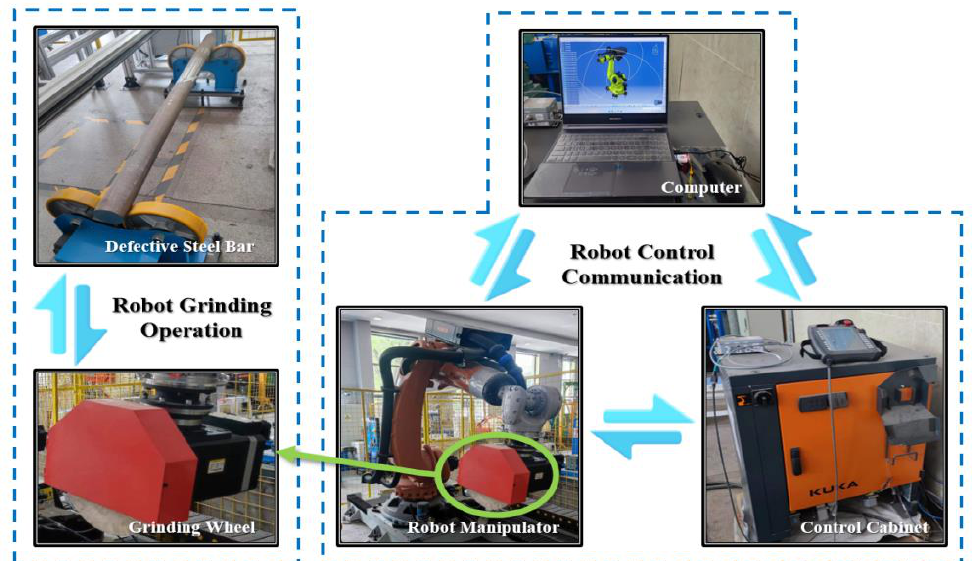
Figure 4. Robot manipulator and grinding system.